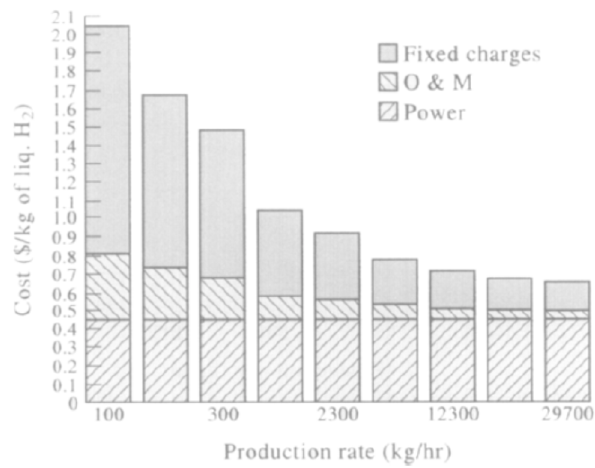
Figure 3. Cost of power, operation and maintenance and fixed charges on capital investment of an optimized large-scale hydrogen liquefier [17].